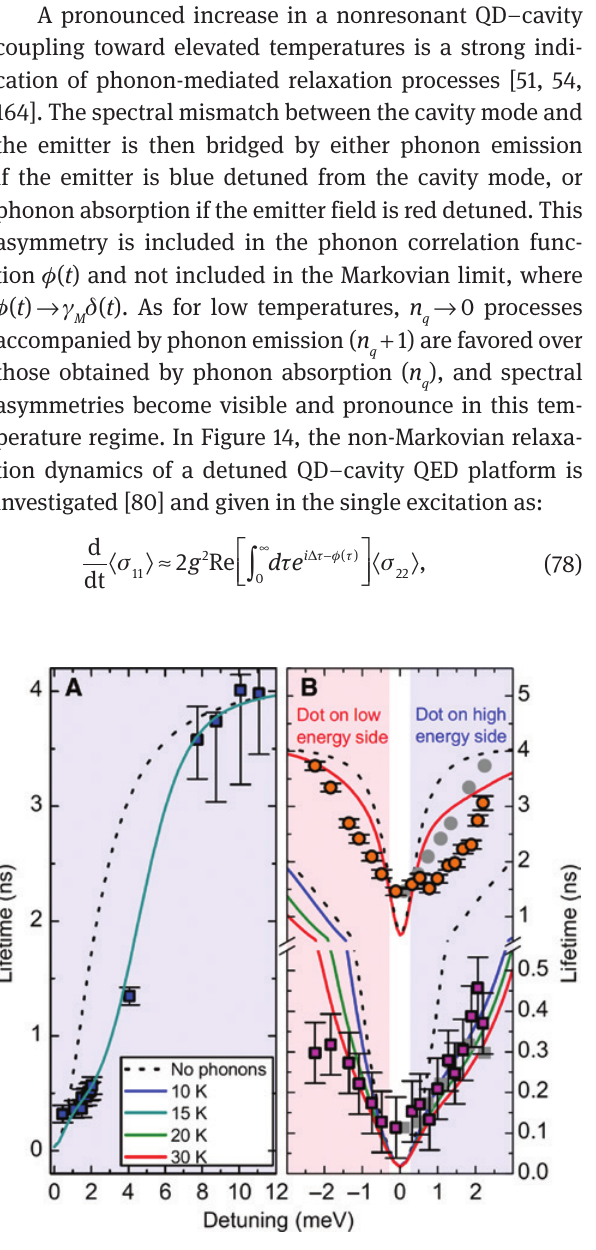
Figure 14: Extracted decay times of a QD–cavity system as a function of